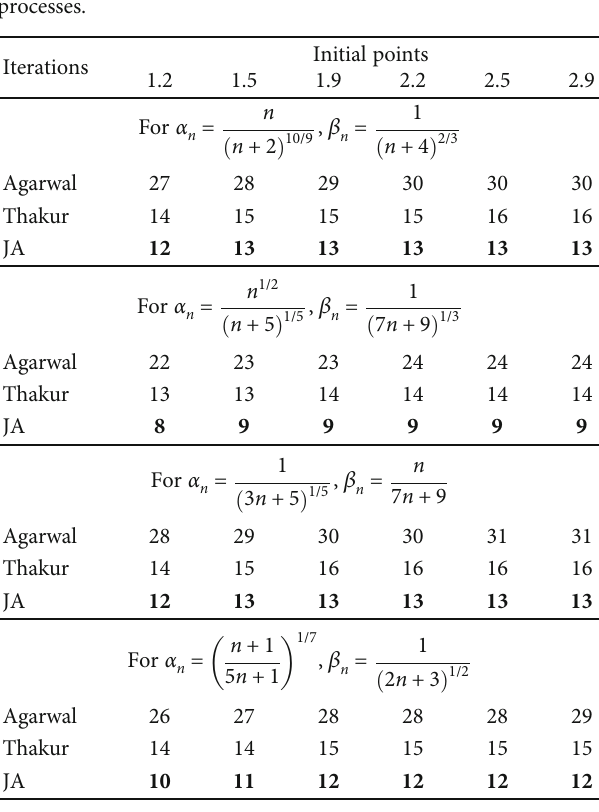
Figure 1: Convergence behavior of JA, Thakur et al., and Agarwal iterative algorithms for mapping f de fi ned in Example 16. Table 2: In fl uence of parameters: comparison of various iteration